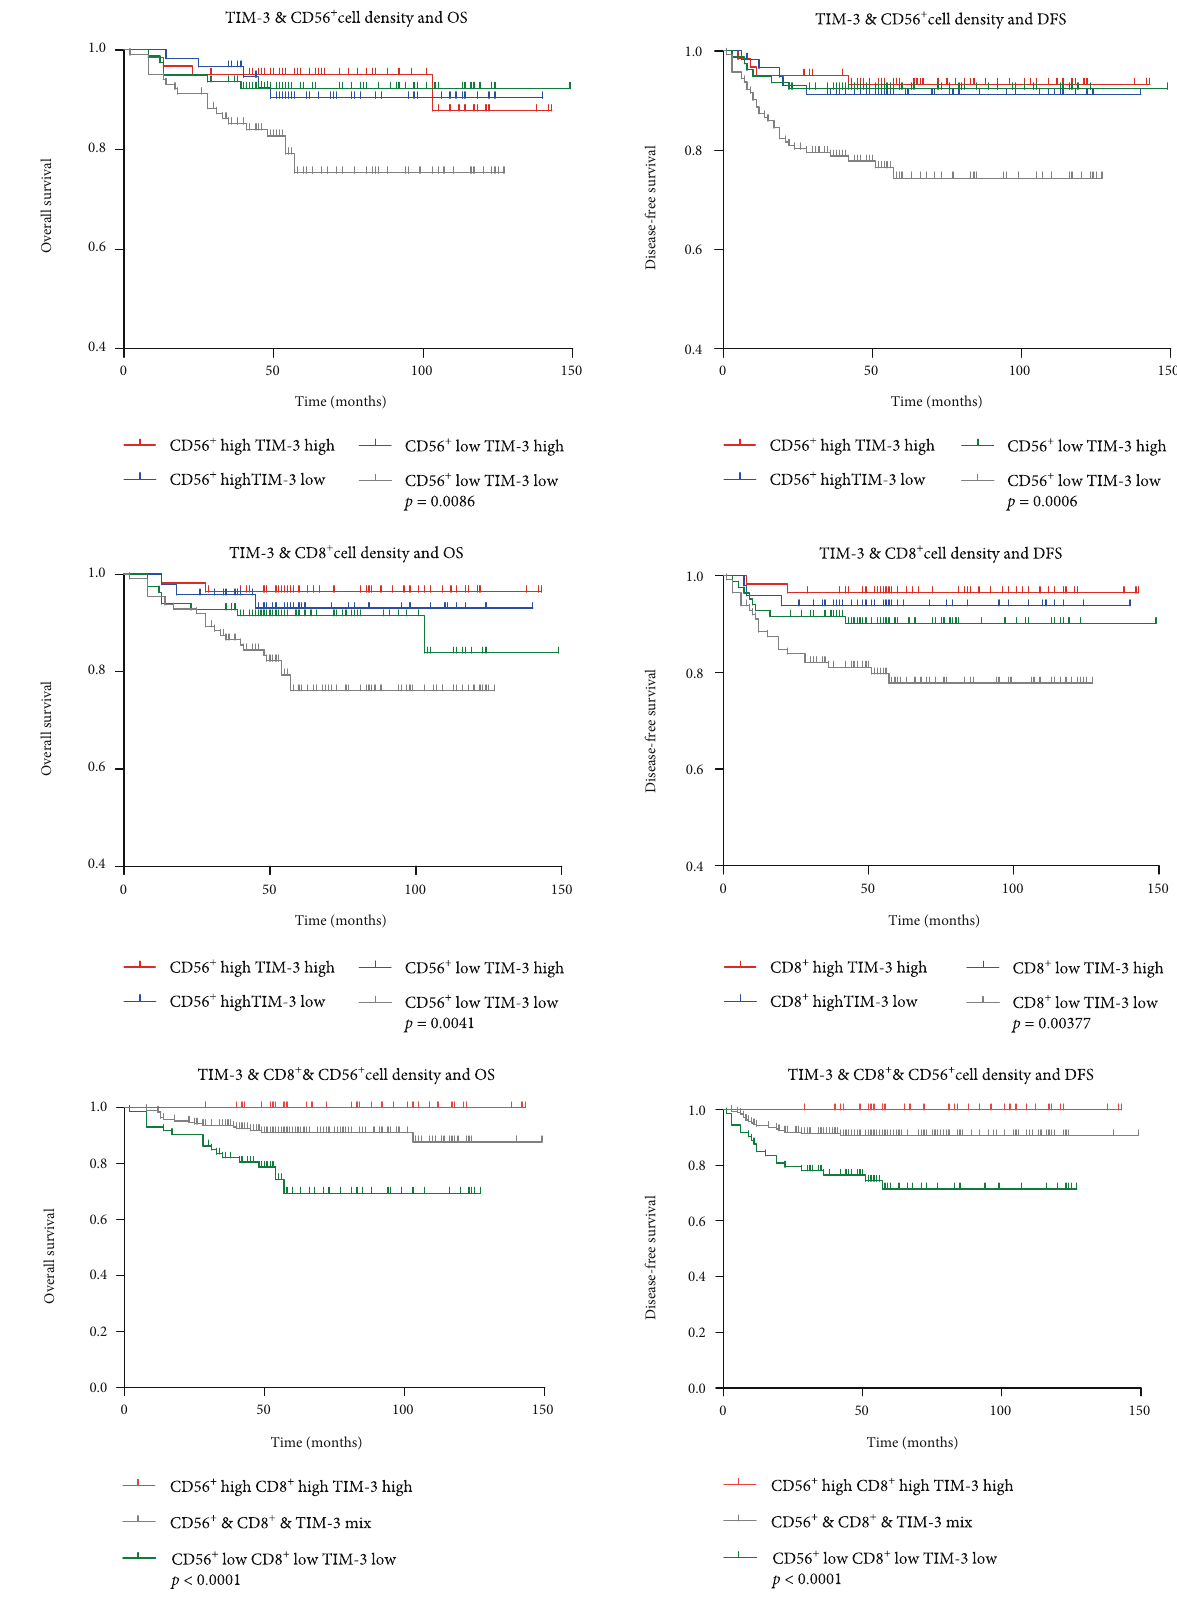
Figure 3: The Kaplan-Meier plots of overall (left column) and disease-free (right column) survival grouped by the integrated TIM-3 + , CD8 + , and CD56 + TIL amount. Low levels of two or three of these TIL markers predicted extremely poor